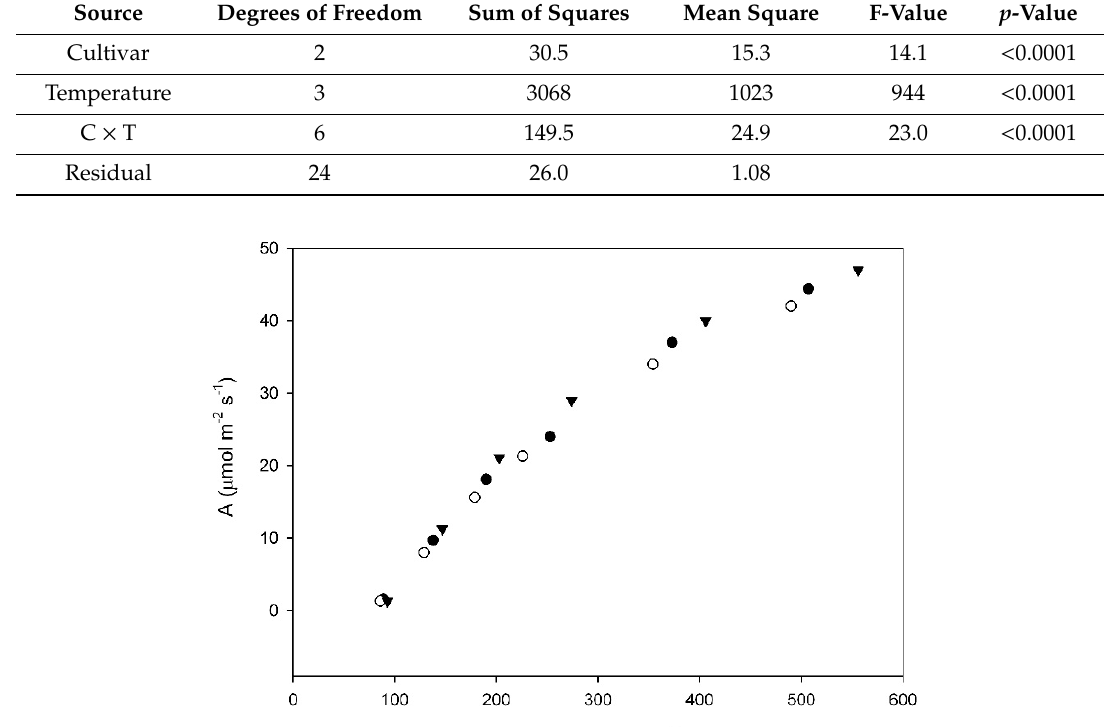
10 of 12 Table A5. Analysis of variance for photosynthetic rates measured at 200 μ mol mol − 1 C i for three soybean cultivars grown at 25 °C.